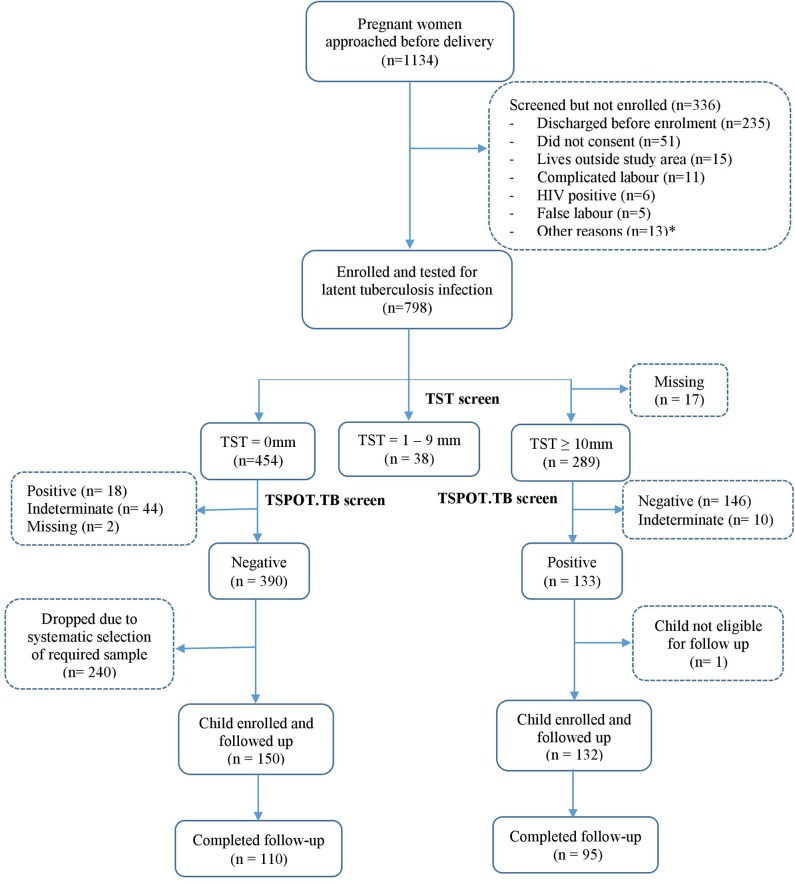
Study flowchart. *Other reasons include discharged before consenting procedures, low birthweight babies, cord blood not taken, asphyxia, child not vaccinated, and birth to twins.